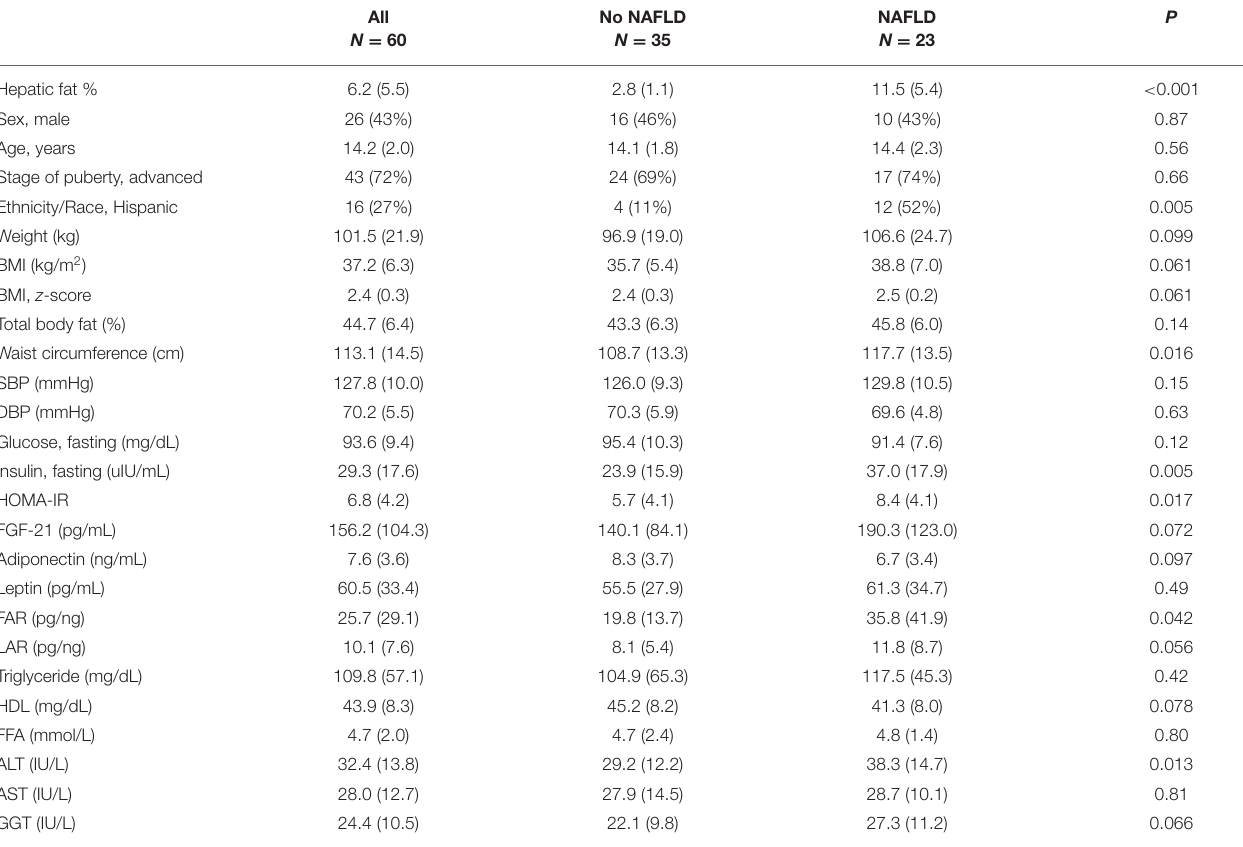
TABLE 1 | Summary of all subject characteristics at baseline and comparison among subjects with and without NAFLD.